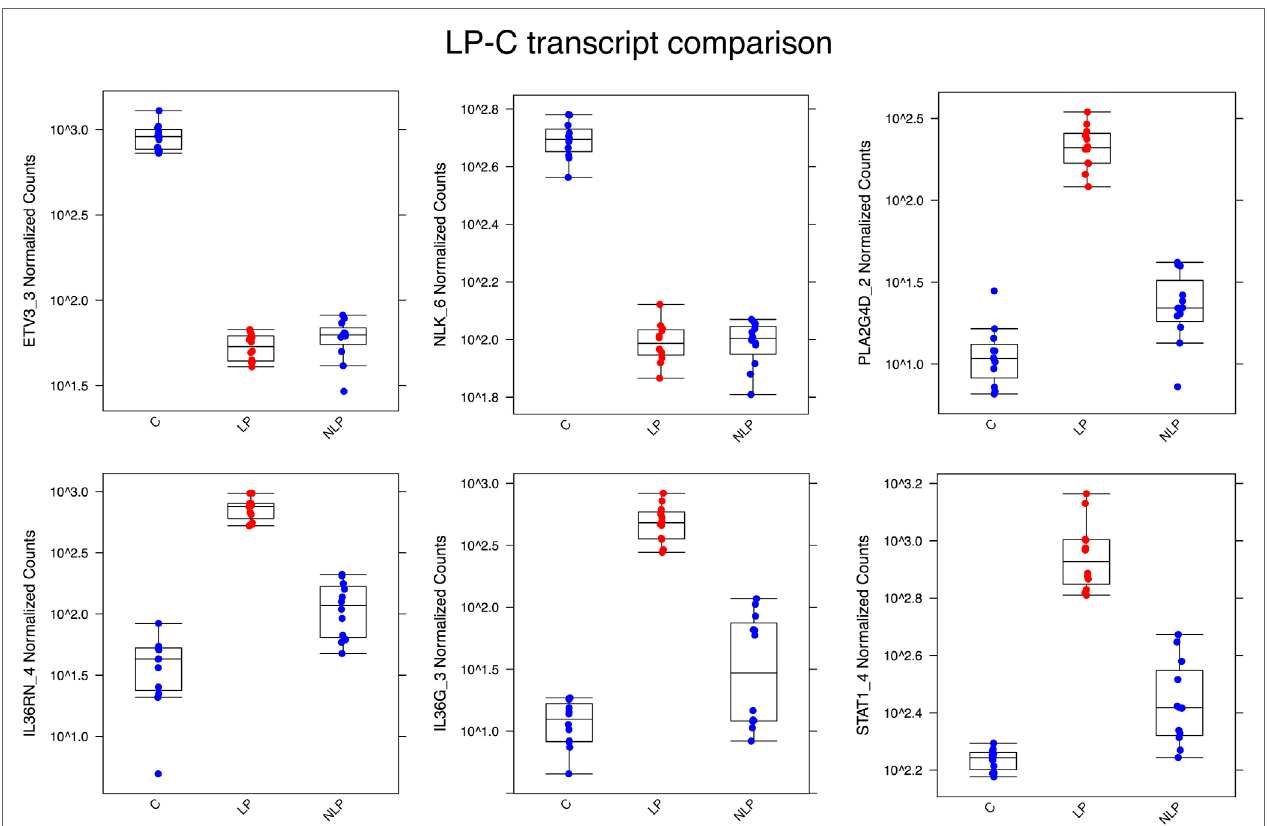
FigUre 2 | Box plots illustrating some of the most differentially expressed transcripts between the lP and c samples . ETV3_3 and NLK_6 were highly expressed in control skin but downregulated in lesional and non-lesional skin. The other genes in the figures were all upregulated in the psoriatic samples, but less so in non-lesional skin. Abbreviations in the X -axis are LP, lesional, NLP, non-lesional, and C,